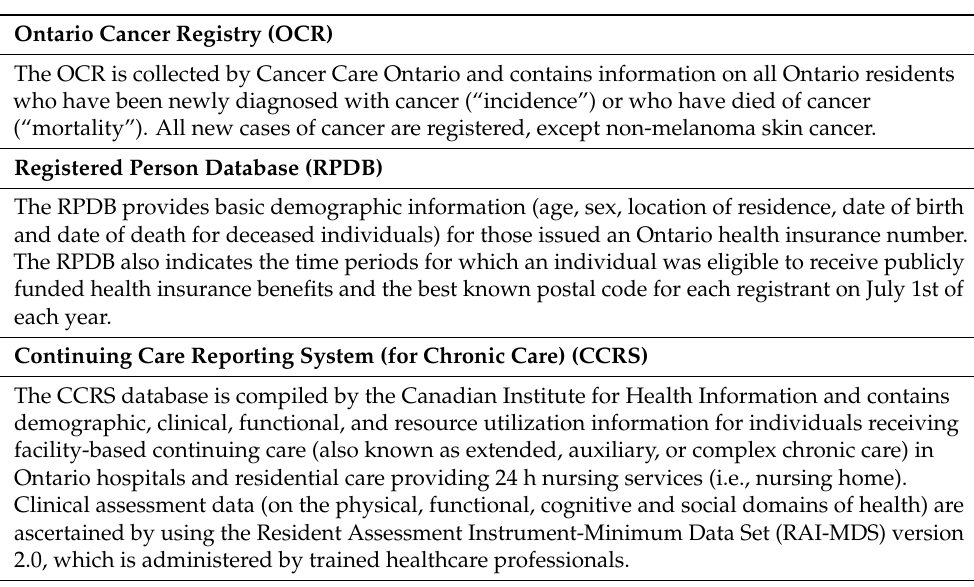
Table A1. Description of databases that informed the development of the study